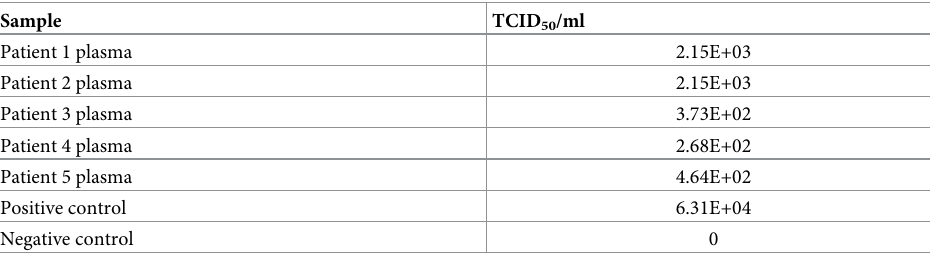
Table 3. MELV titers in